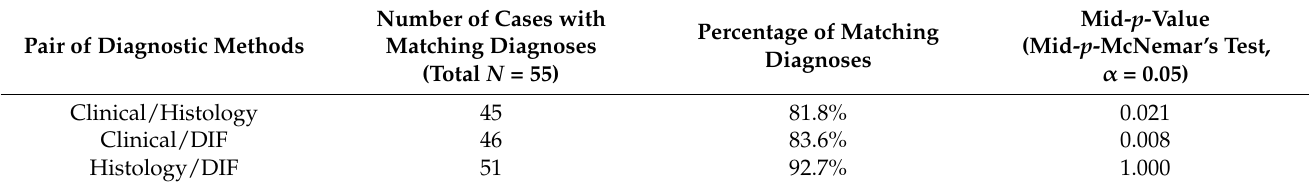
Table 6. Differences Between the Paired Diagnostic Methods Of the Intraepidermal Blister Subgroup.